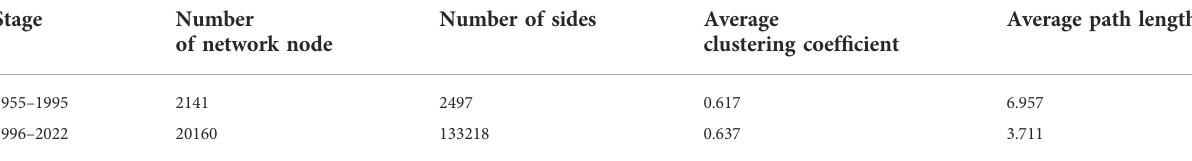
TABLE 2 Basic parameters of cooperative networks in different stages of cobalt key technologies.